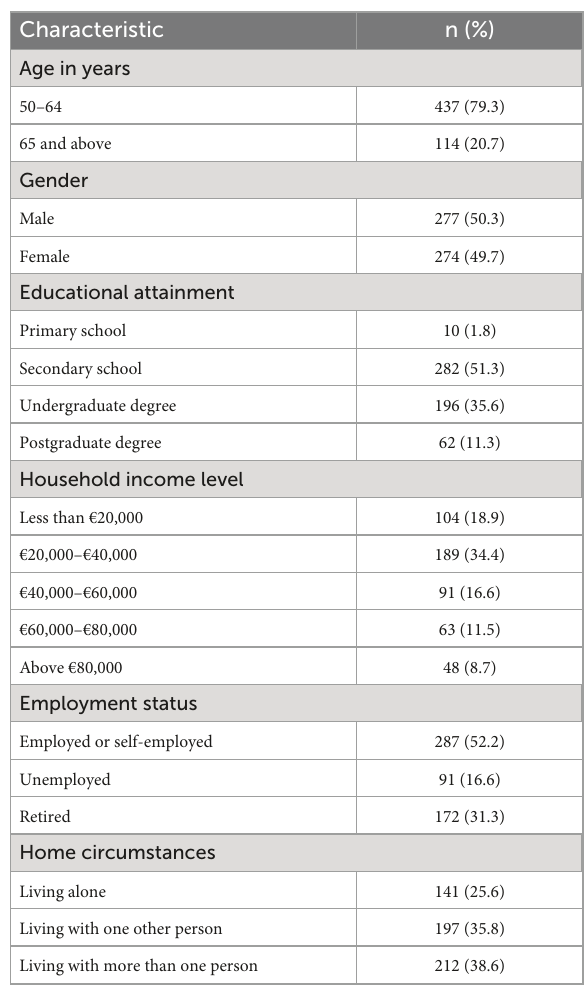
TABLE 1 Sociodemographic characteristics of the